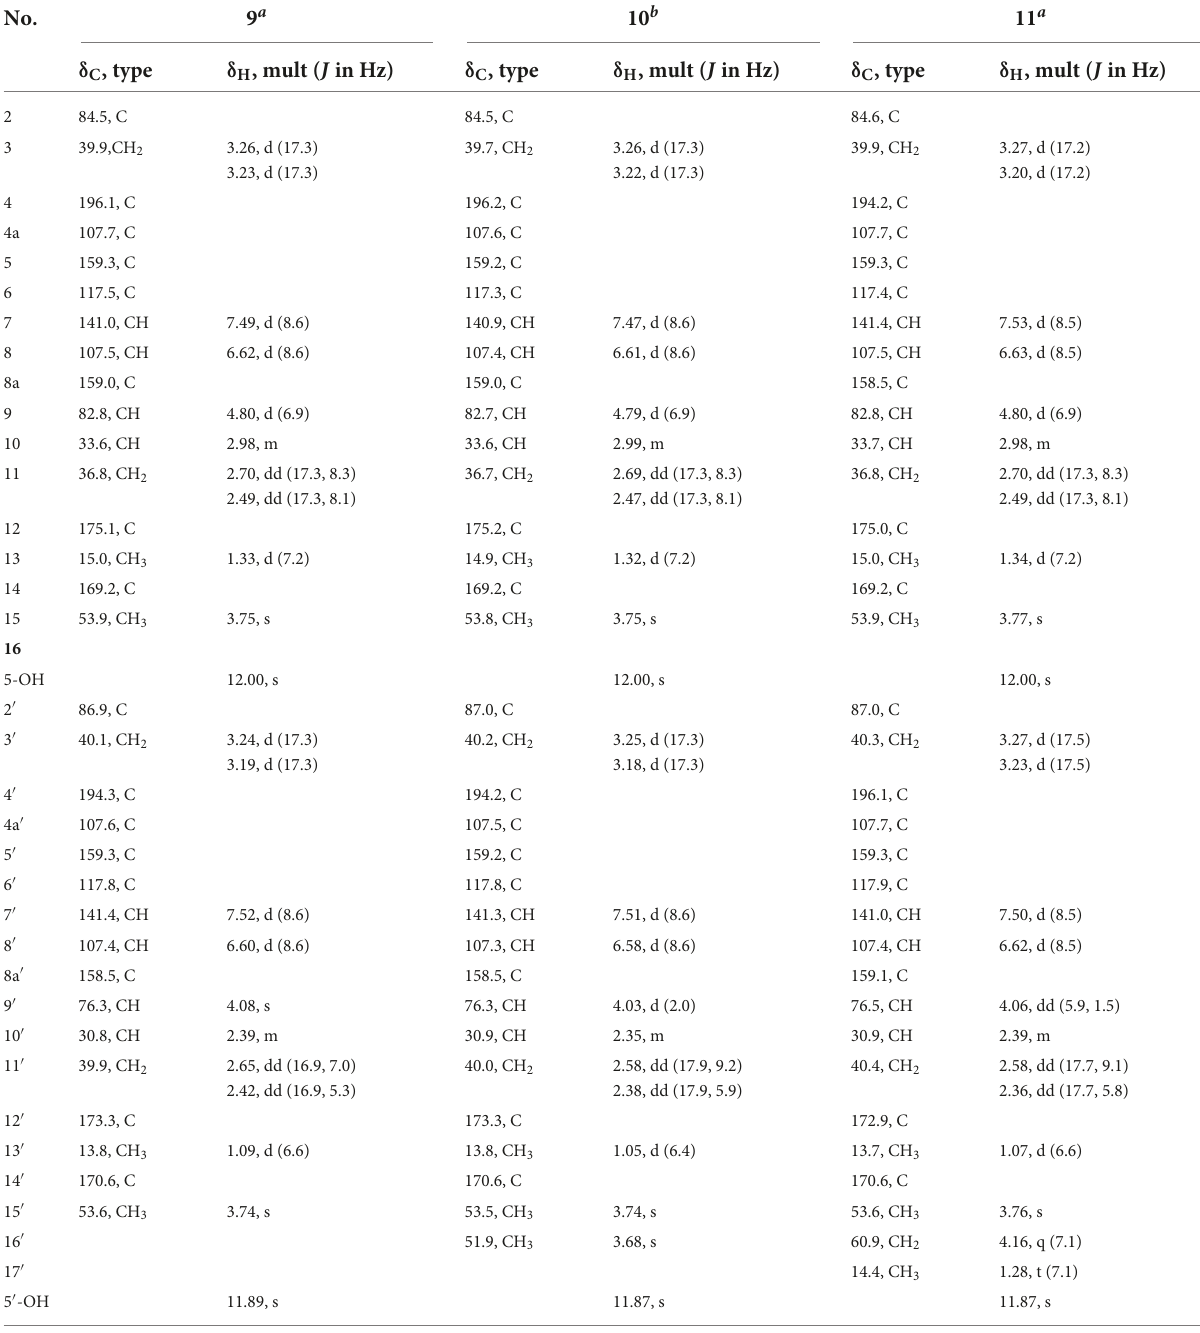
TABLE 4 1 H and 13 C NMR spectroscopic data of Compounds 9 , 10, and 11 (CDCl 3 ). No. 9 a 10